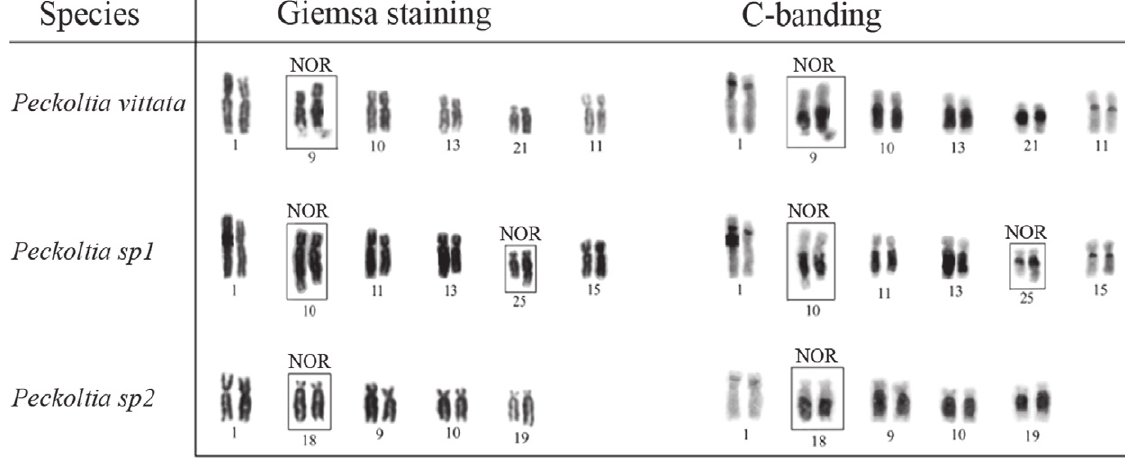
Fig. 4. Possible homologies among species of the Peckoltia genus, as determined via conventional staining, C-banding and NOR